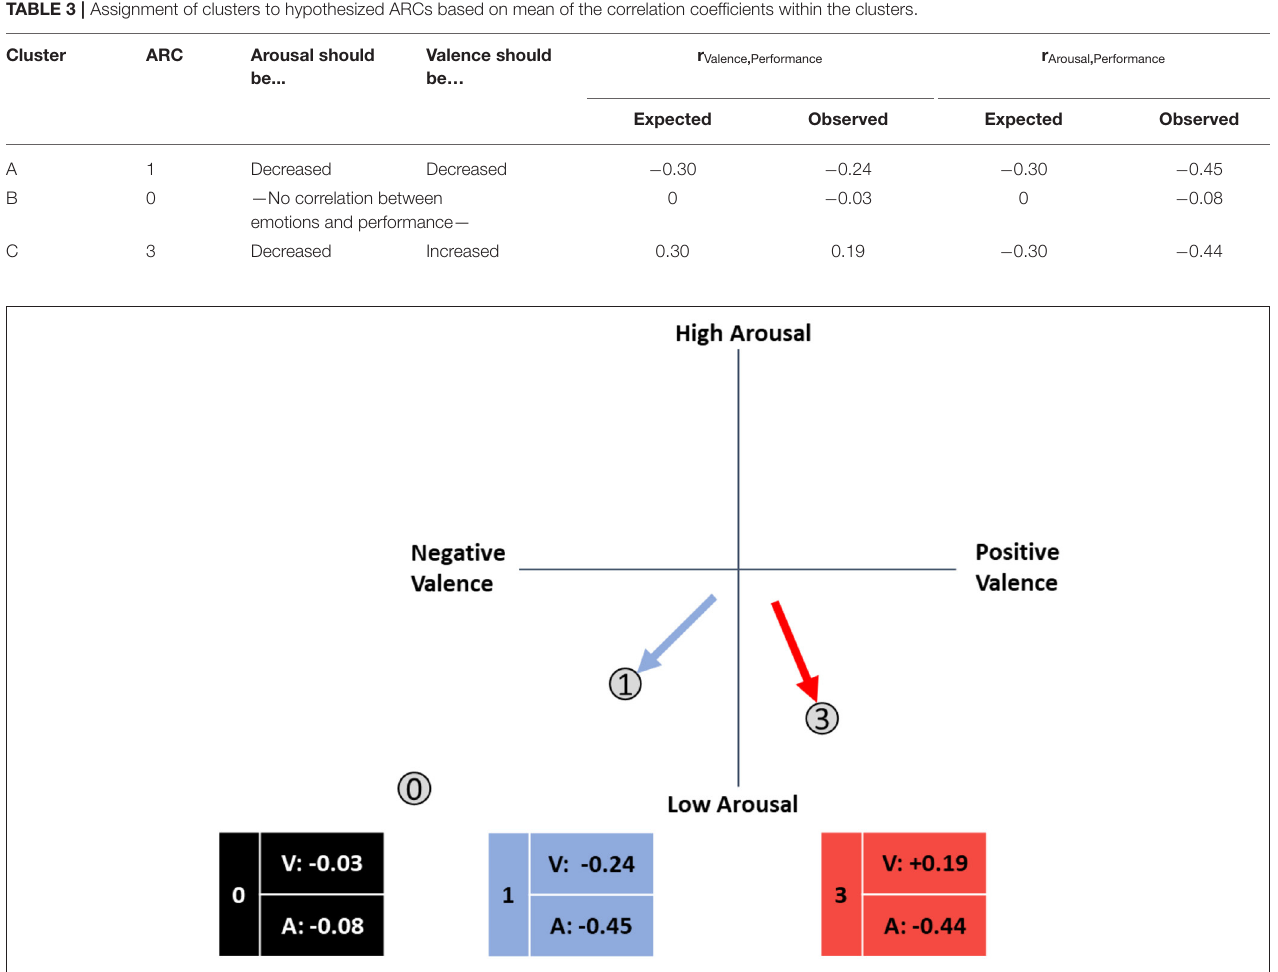
FIGURE 9 | Average correlation coefficients in ARCs based on cluster analysis in the circumplex model of affect (adapted from Russell, 1980).